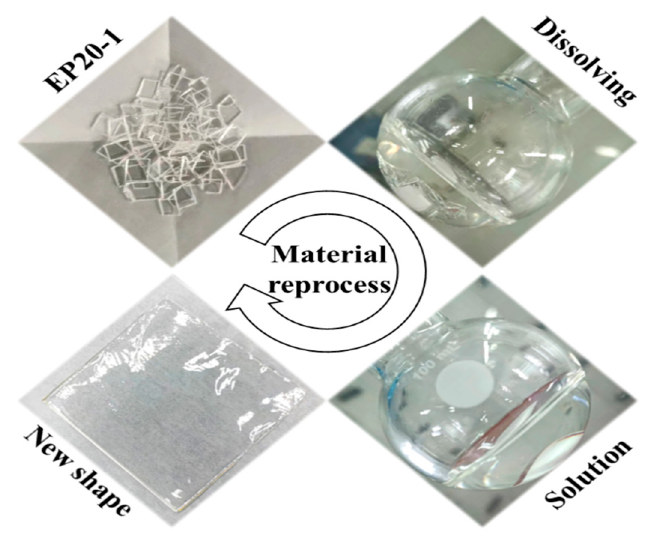
Figure 13. Recycling performance of EP20-1.